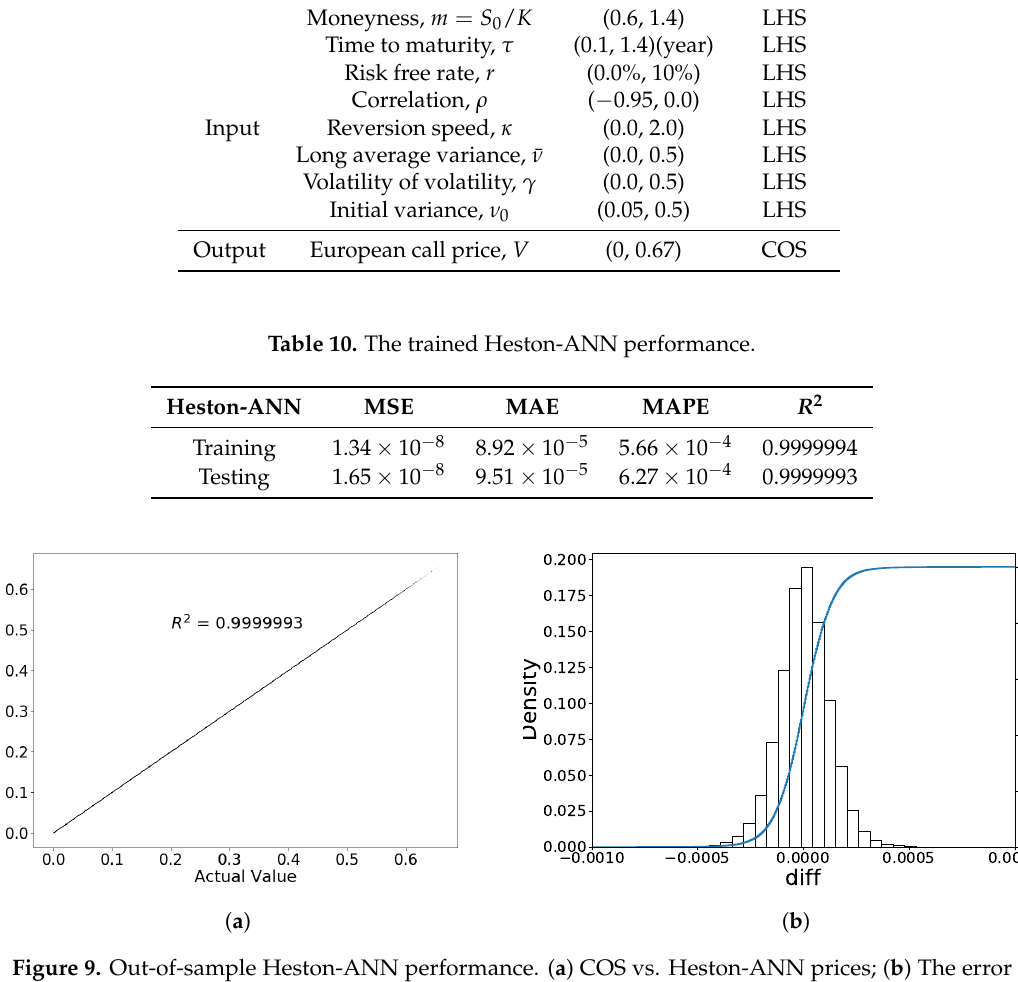
Figure 9. Out-of-sample Heston-ANN performance. ( a ) COS vs. Heston-ANN prices; ( b ) The error